Question: Provide a one-line summary of what is displayed.
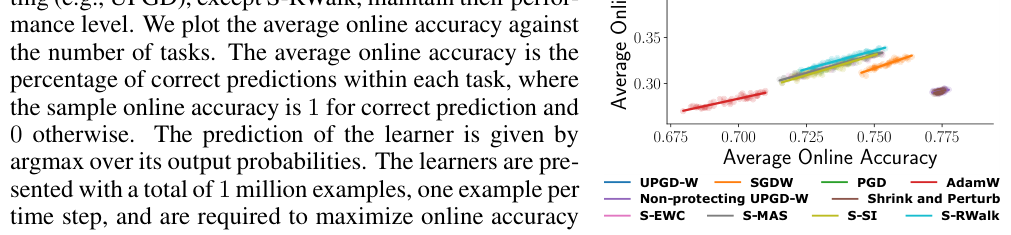
Answer: Each method’s average plas- ticity against average accuracy of on Input-permuted MNIST.